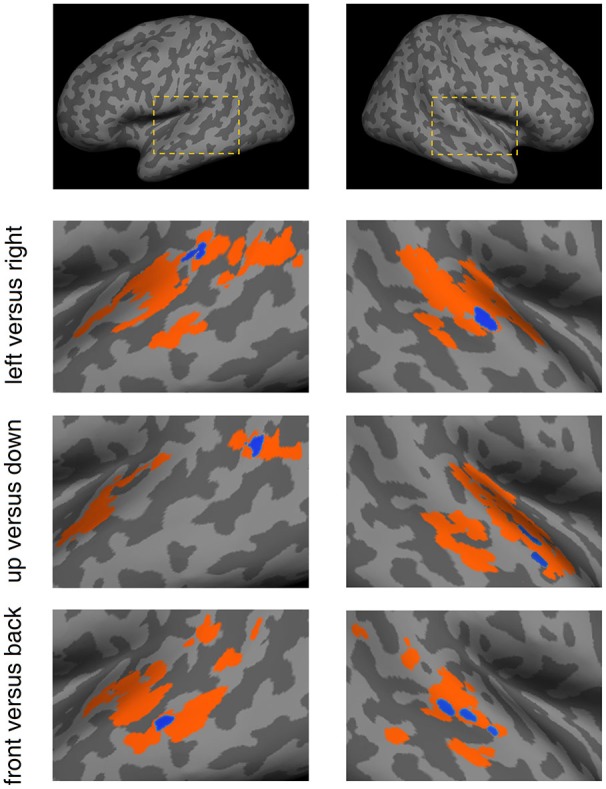
Spatial patterns of effective voxels (EV) within the temporal lobe for the different discrimination conditions. For each condition, the voxels displayed in color were obtained from the permutation test-based voxel selection procedure. Orange signifies voxels selected in at least one subject and blue signifies voxels selected in three or more subjects. Blue voxels were referred to as Significant Effective Voxels (SEVs). The dashed boxes in the top panels depict the location of these results in the brain.